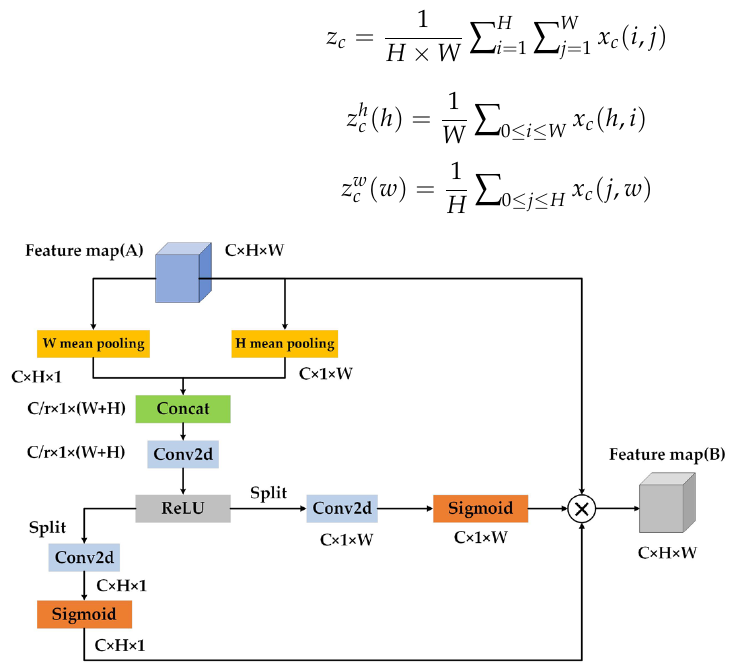
Figure 8. Coordinate attention module structure.